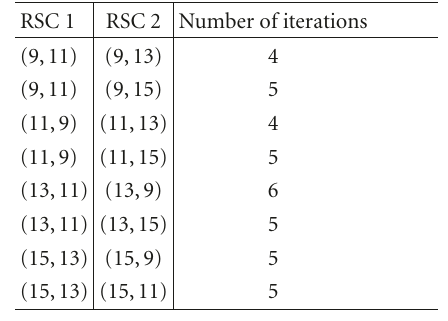
Table 2: Number of iterations for various generator polynomial combinations.